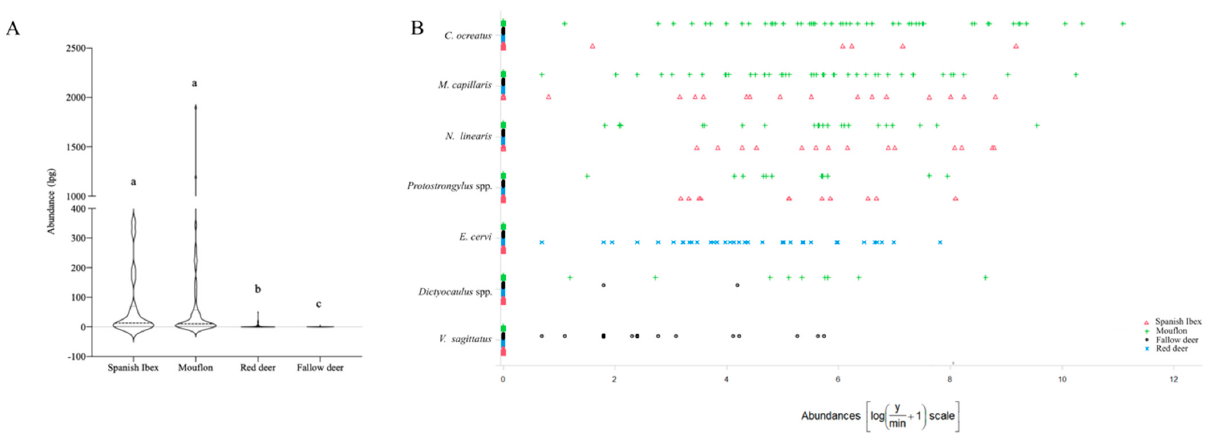
Figure 3. Abundance of total identified nematodes ( A ) and the seven commonly found parasites ( B ) described in all studied wild ruminants. 0. Different letters (a,b,c) in figure A indicate a significant effect.